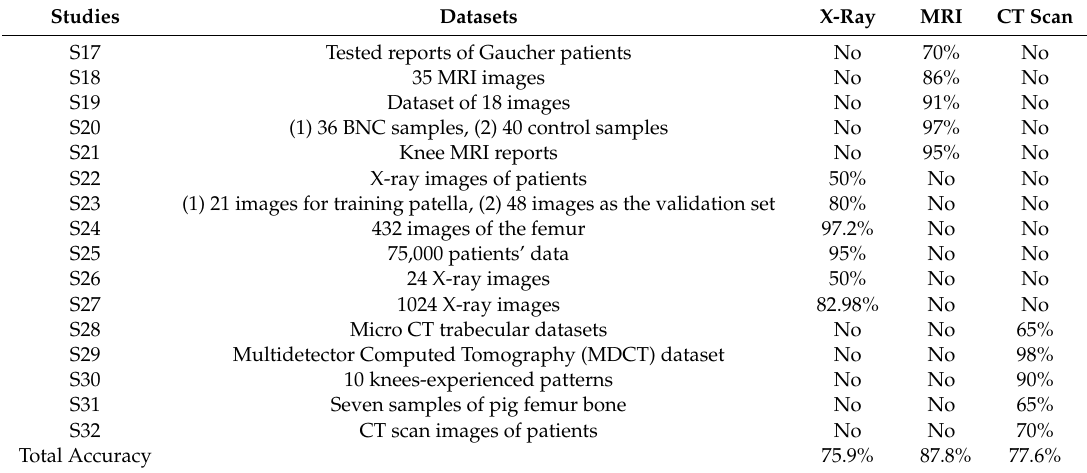
Table 18. Accuracy of machine learning